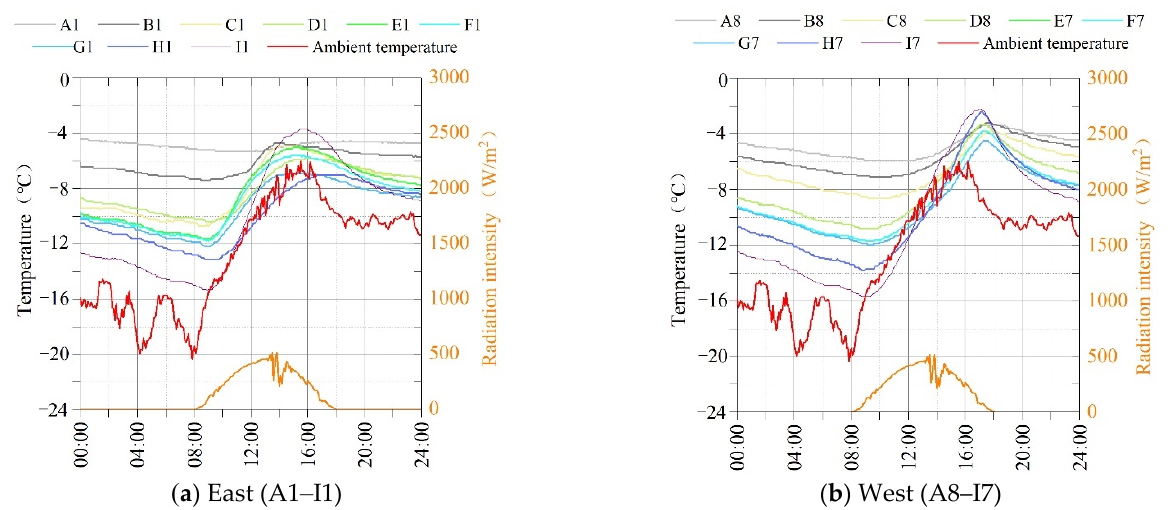
Figure 26. The relationship of wall temperature, atmospheric temperature and the weakest solar radiation (19 January 2018).